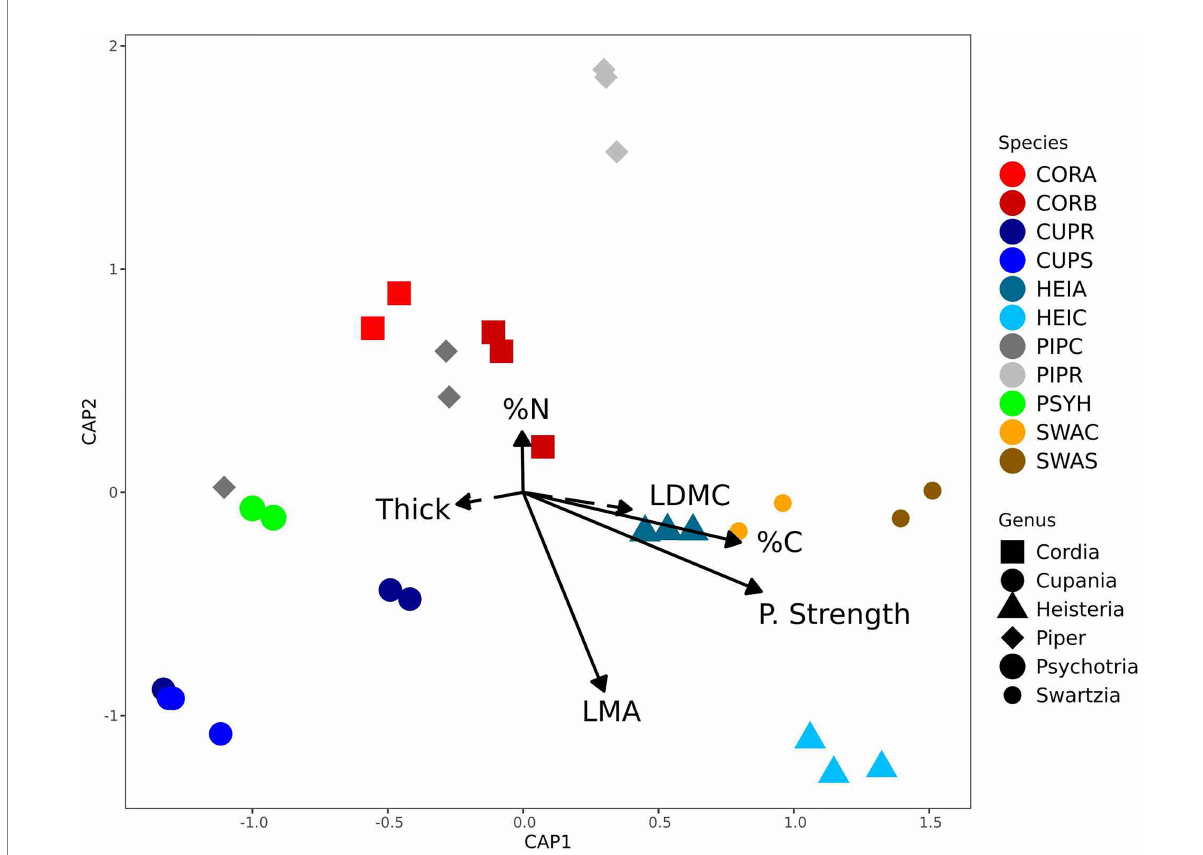
FIGURE 2 Endophyte community composition was associated with leaf traits from the leaf economics spectrum (culture-free data set). Endophyte community variation within and between 11 host species in six genera ( n = 29), from distance-based redundancy analyses (dbRDA) models constrained by leaf traits. Solid arrows represent significant associations ( p < 0.05). Each point represents an endophyte community sampled from one host tree; colors represent host species; and symbols represent host genus (for a list of host species abbreviations, see Table 1).